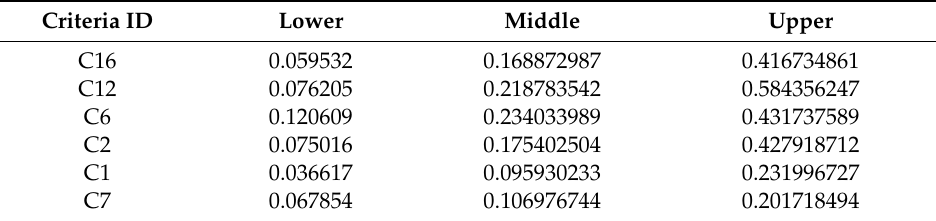
Table 11 calculates the fuzzy decision matrix and the fuzzy positive ideal solution, as well as the fuzzy negative ideal solution (where H, hydro; S, solar; B, biofuel; W, wind; N, FNIS; and P,